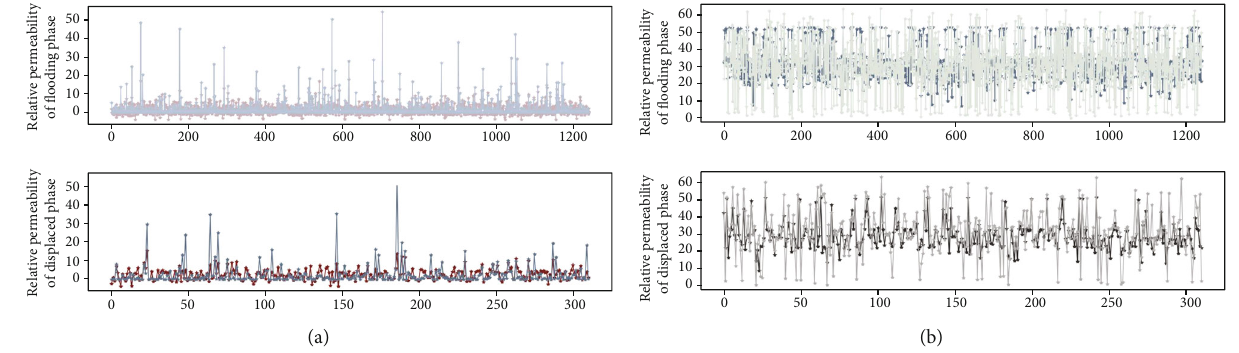
Figure 9: The training and testing results of the DNN: (a) the training process and validation results of the intelligent relative permeability model of the fl ooding phase; (b) the training process and validation results of the intelligent relative permeability model of the displaced phase.